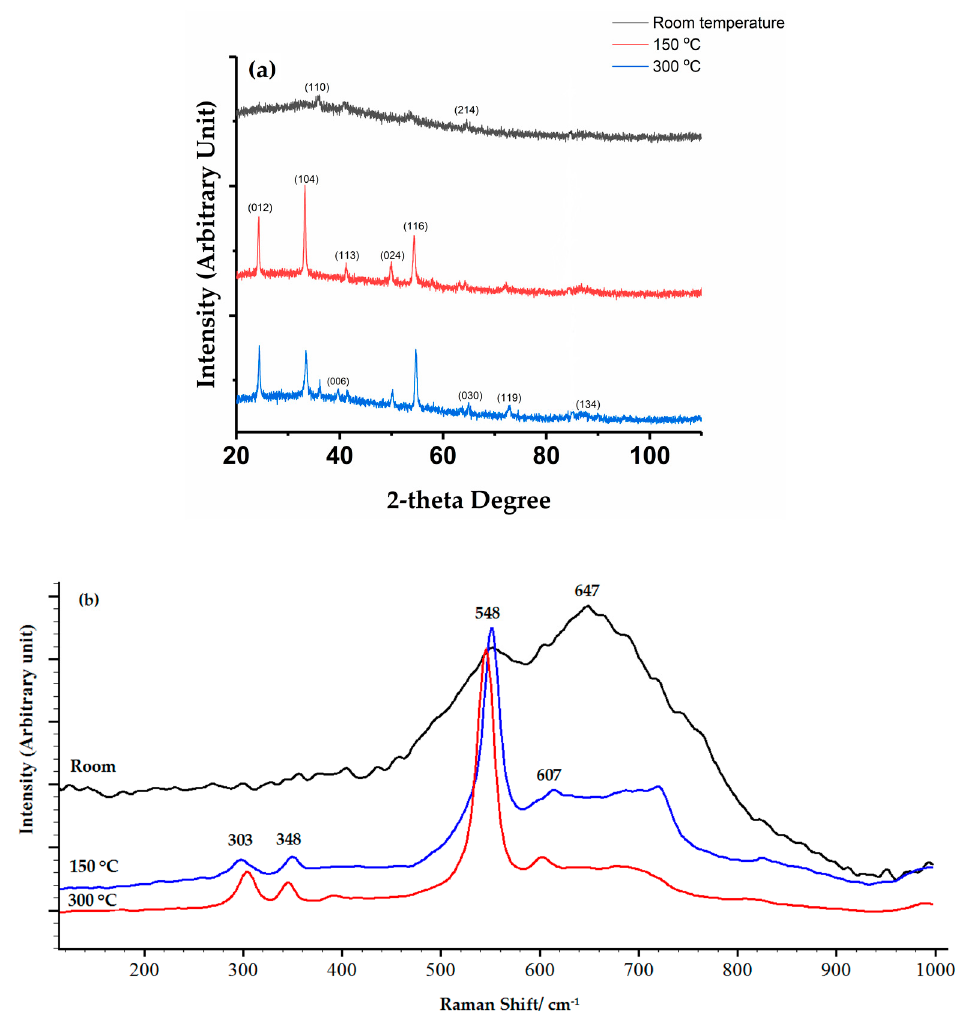
Figure 5. ( a ) XRD patterns and ( b ) Raman spectra of chromium oxide coatings deposited at different temperatures.